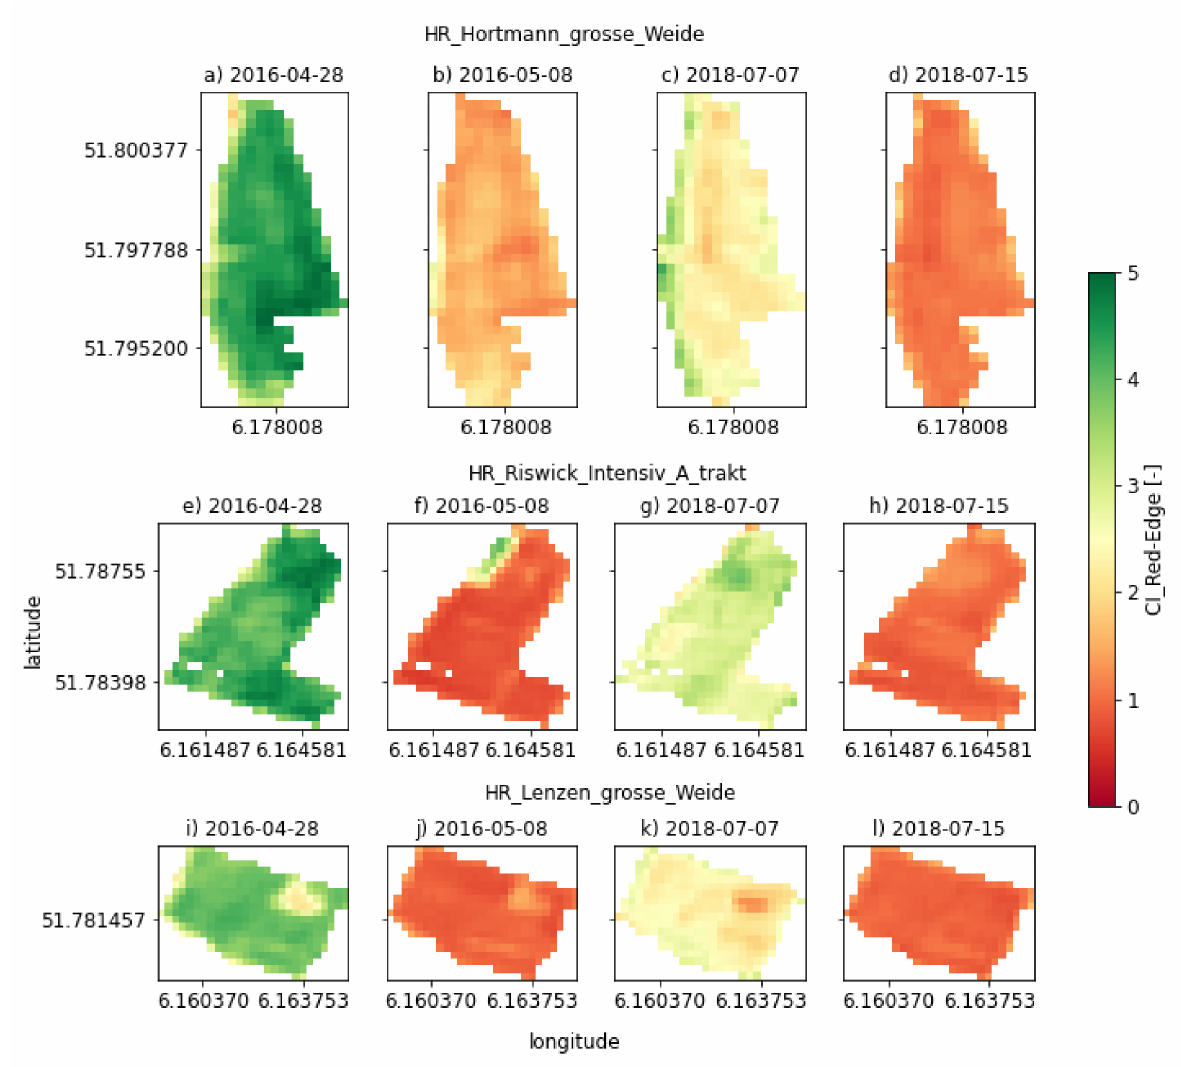
Figure 5. Vegetation index images ( CI Red-Edge ) for the three parcels Hortmann grosse Weide ( a – d ), Riswick Intensiv A-trakt ( e – h ), and Lenzen grosse Weide ( i – l ), which are shown in pairs: just before and right after harvest for selected dates in the growing seasons of 2016 and